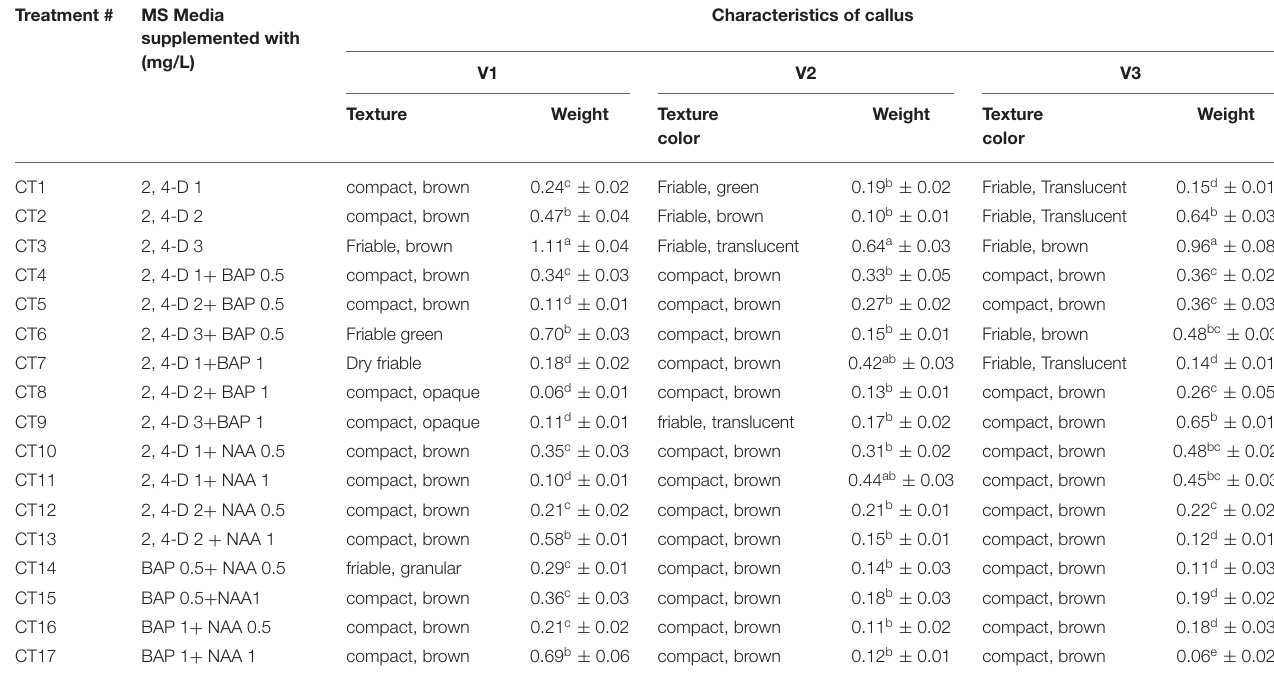
TABLE 3 | Effect of various concentrations and combinations of different growth regulators on callus cultures of three selected varieties of mung bean. Treatment